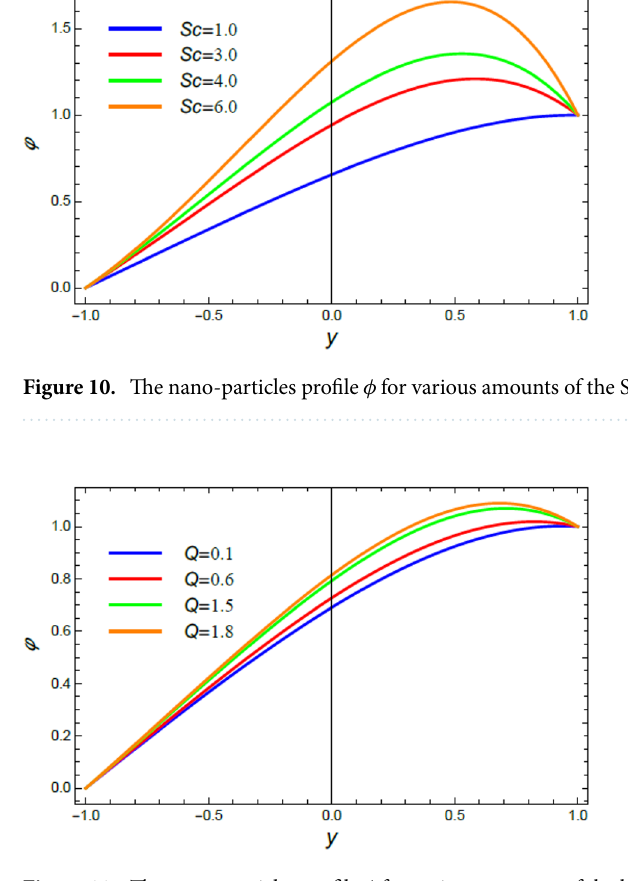
Figure 11. The nano-particles profile φ for various amounts of the heat source coefficient Q